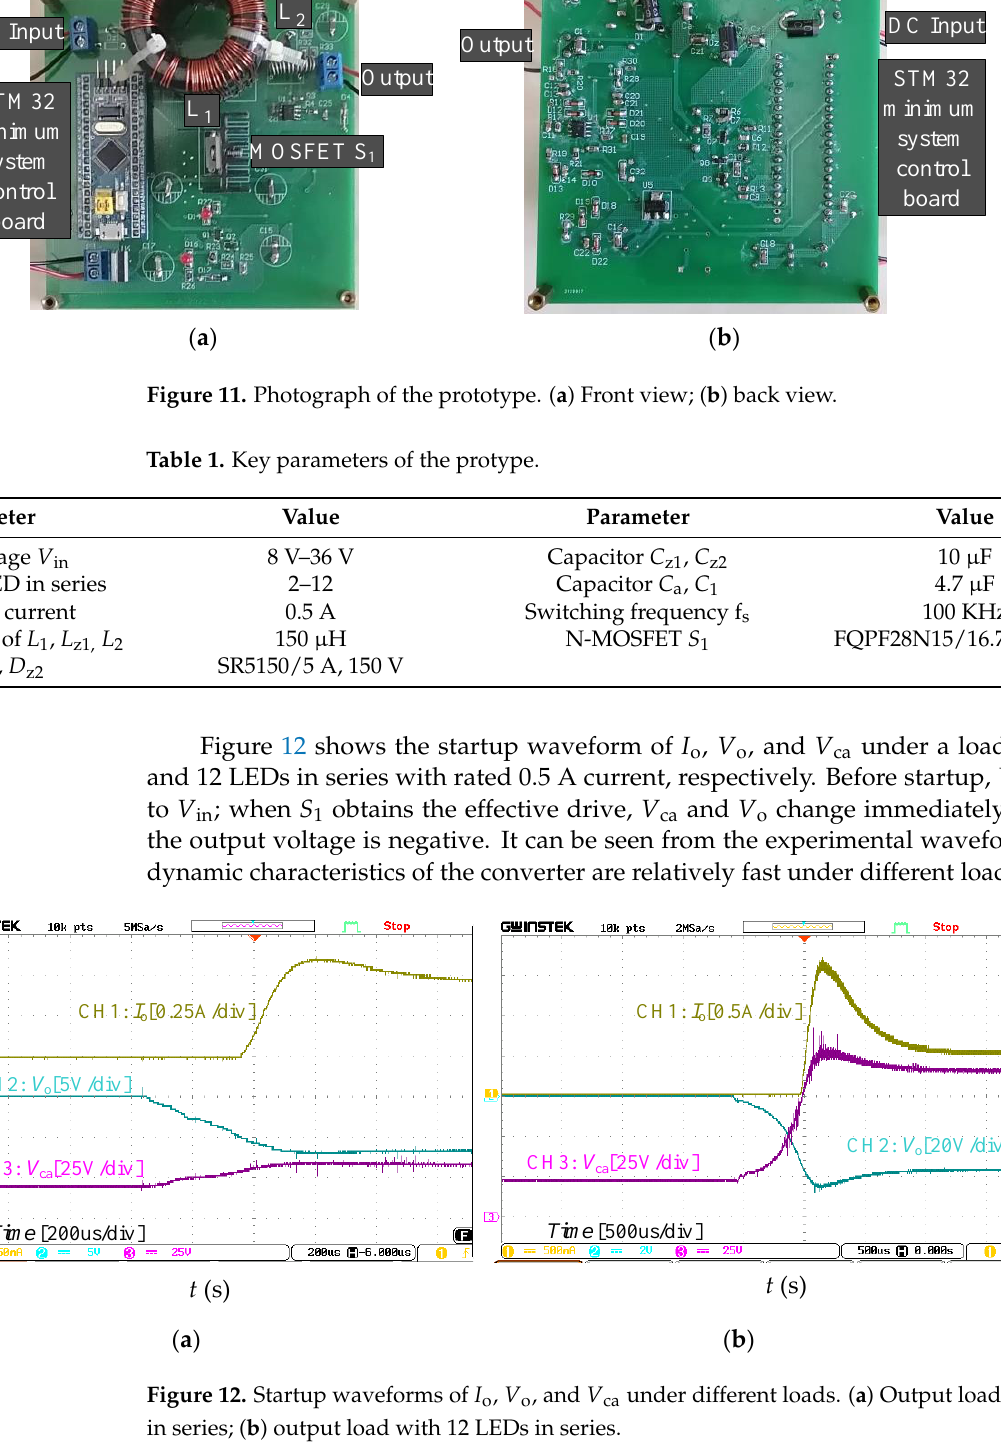
( b ) Figure 13. Steady-state waveforms of I o , V o , and V ca under different loads. ( a ) Output load with 2 LEDs in series; ( b ) output load with 12 LEDs in series. Figure 14 shows the efficiency of the converter when the input voltage range is 8 – 36 V, where the corresponding number of load LEDs in series N led is 2,6,10,12, and the rated output current is 0.5 A. It can be seen that the system efficiency increases gradually with the increase in input voltage and load. As the input voltage increases, the input current decreases, and the switch turn-off voltage rises. However, the decrease in the input cur- rent seems to have a greater impact on the efficiency.